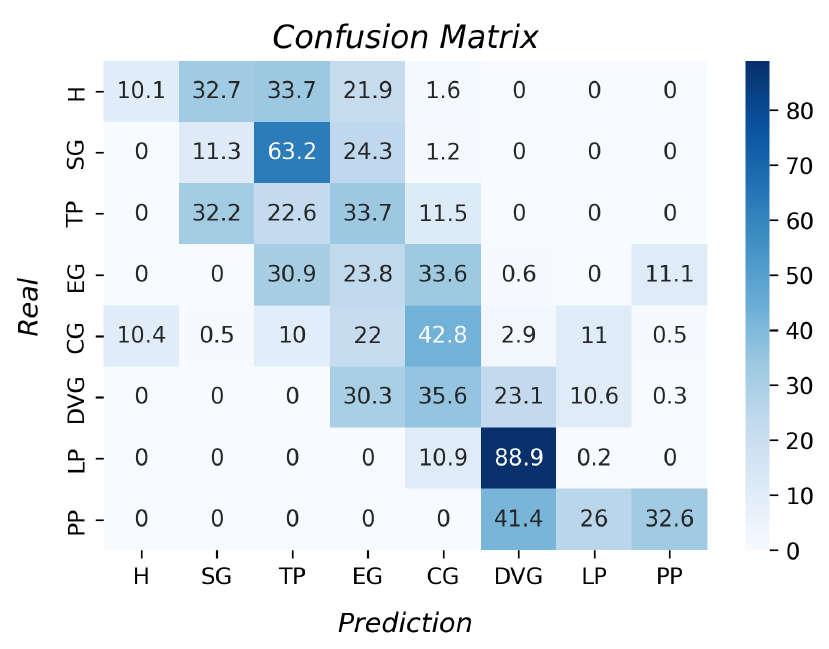
Figure 12. Accuracy per type of grasp for the linear regression algorithm.